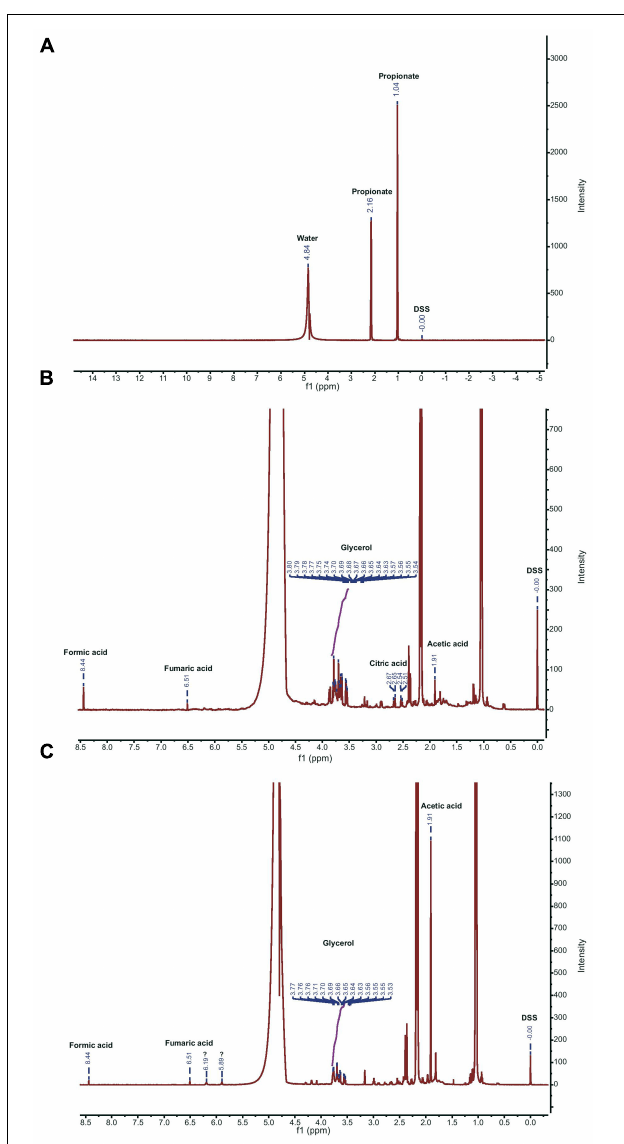
FIGURE 4 | Proton NMR spectra of M9 medium, and fungal exudates. (A) M9 spectrum showing peaks corresponding to water and propionate. (B) Full spectrum of exudates of Lyophyllum sp. strain Karsten. (C) Full spectrum of exudates of T. asperellum 302. 3-(trimethylsilyl)-1-propanesulfonic acid sodium salt (DSS) was used as the internal standard (0.0 ppm). Corresponding peaks of compounds in exudates of Lyophyllum sp. strain Karsten (B) and T. asperellum 302 (C) are annotated with their names. Unknown peaks are denoted by (?).